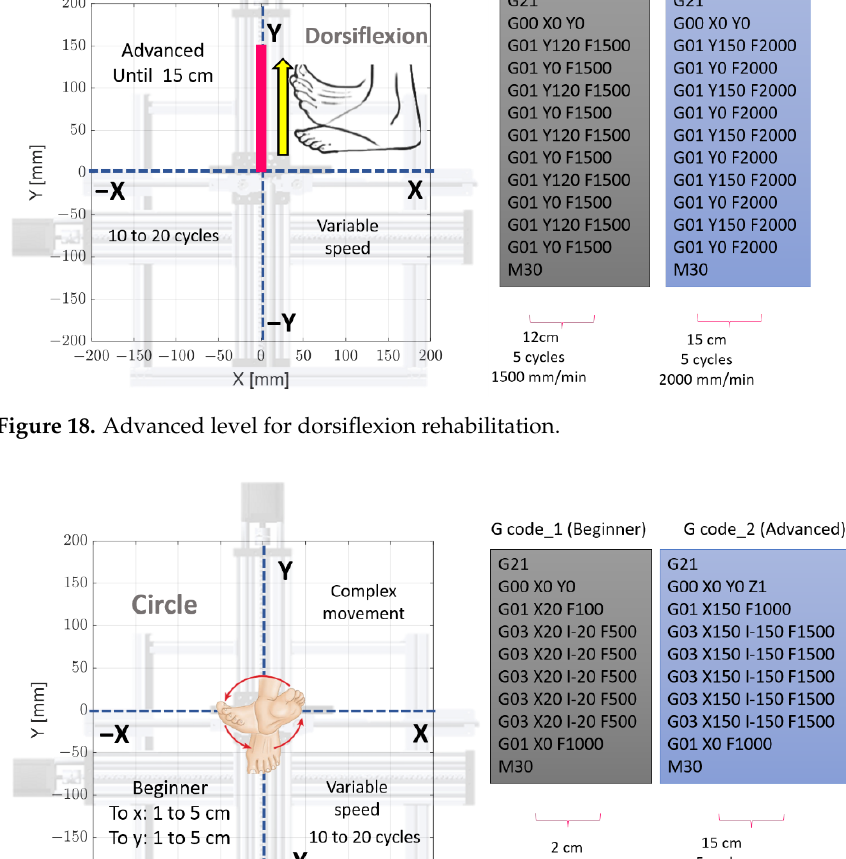
Figure 18. Advanced level for dorsiflexion rehabilitation.